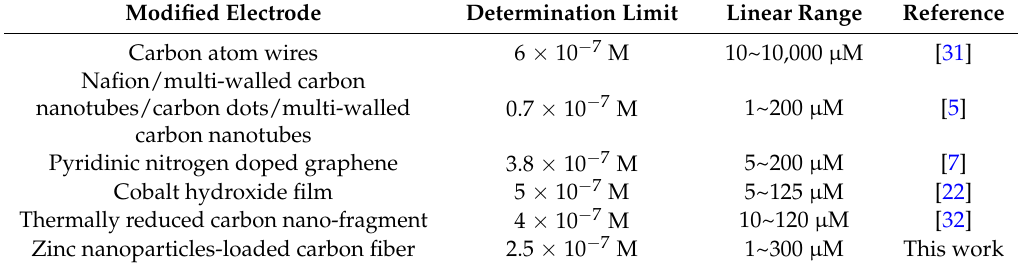
Figure 7. Cyclic voltammograms of ZCF-modified GCE with the HQ concentration between 1 × 10 − 6 ~5 × 10 − 3 mol/L at a scan rate of 20 mV/s ( a ) the current varies with the HQ concentration; ( b ) the relation curve of oxidation peak current and HQ concentration. Table 2. Comparison of electrocatalytic oxidation performance of the HQ on different modified electrodes.